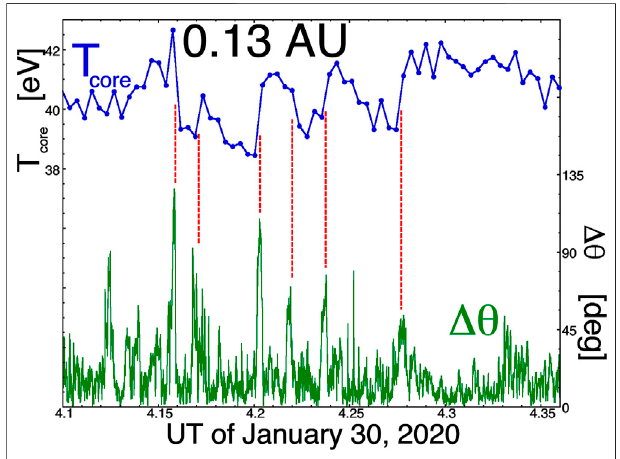
FIGURE 7 | For 15.6 min of time-series measurements by Parker Solar Probe on January 30, 2020 the relationship between jumps in the core- electron temperature(blue curve) and current-sheet crossings asindicated by strongtemporalchangesinthemagnetic- fi elddirection(greencurve)are examined.